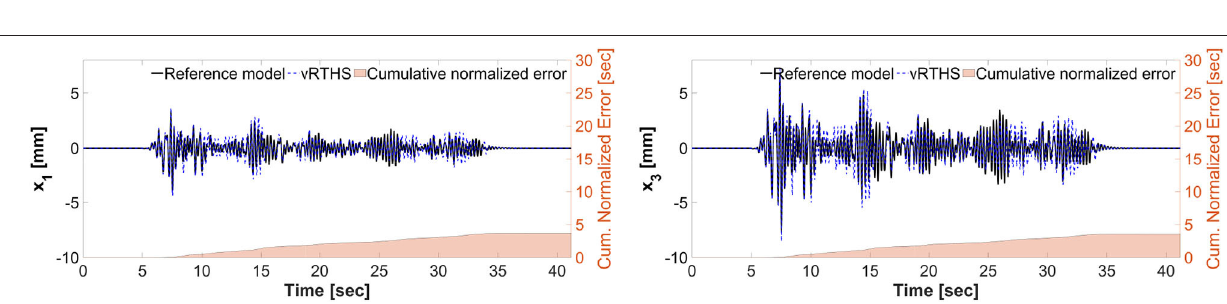
0 < = RSI < = 0:7), and slightly sensitive (green, RSI < 0),